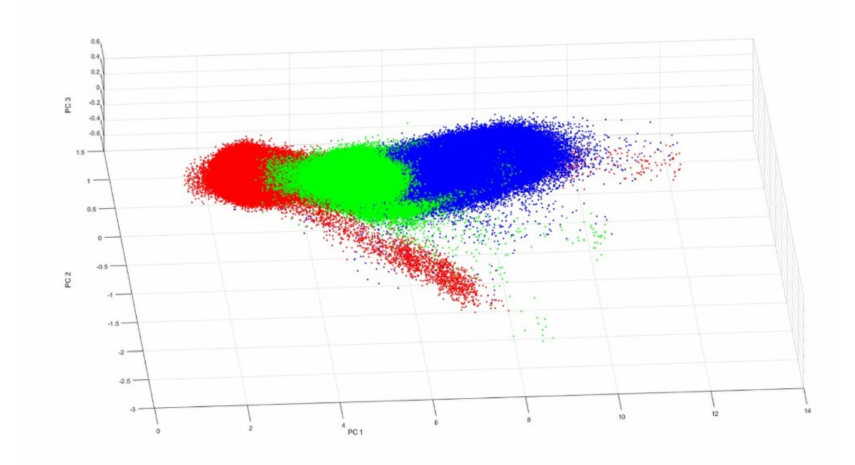
Figure 11. Representation of the first three principal